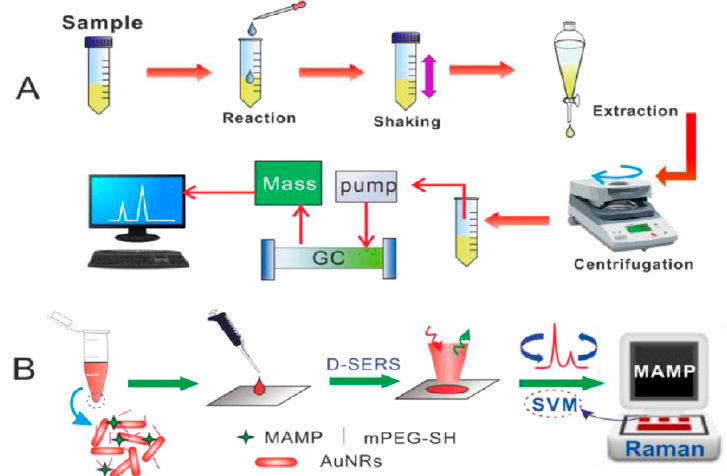
Figure 6. Comparison of drug detection in urine by ( A ) a standard procedure versus ( B ) the D-SERS and support vector machines (SVM) solution (Dong. et al. [100]).